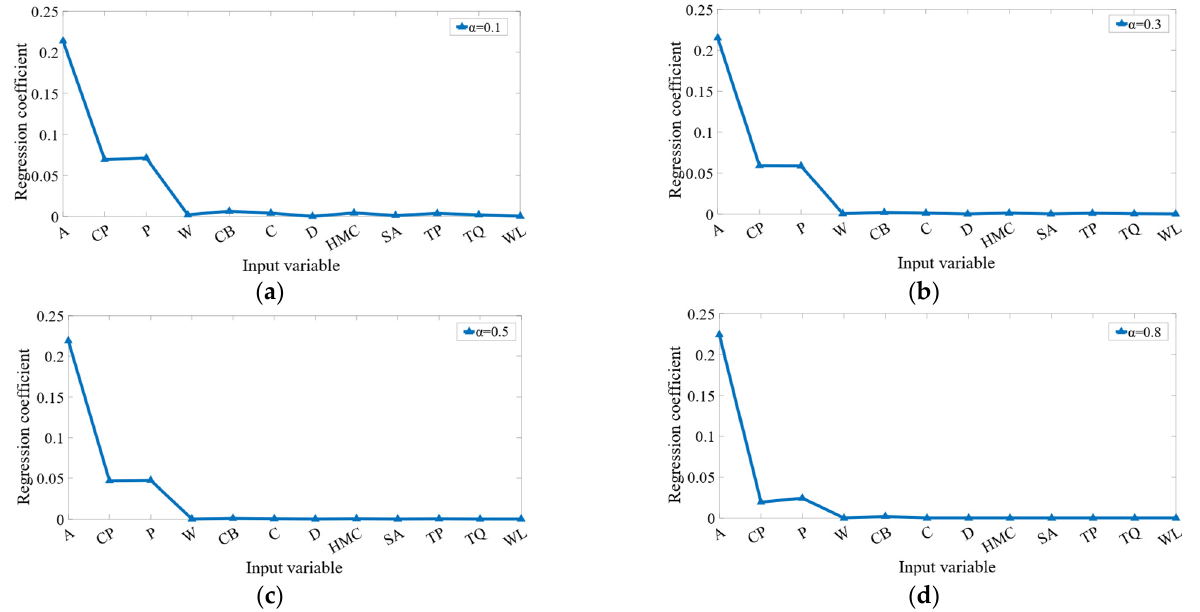
Figure 7. The absolute values of compressed regression coefficients as α set to ( a ) 0.1, ( b ) 0.3, ( c ) 0.5, ( d )